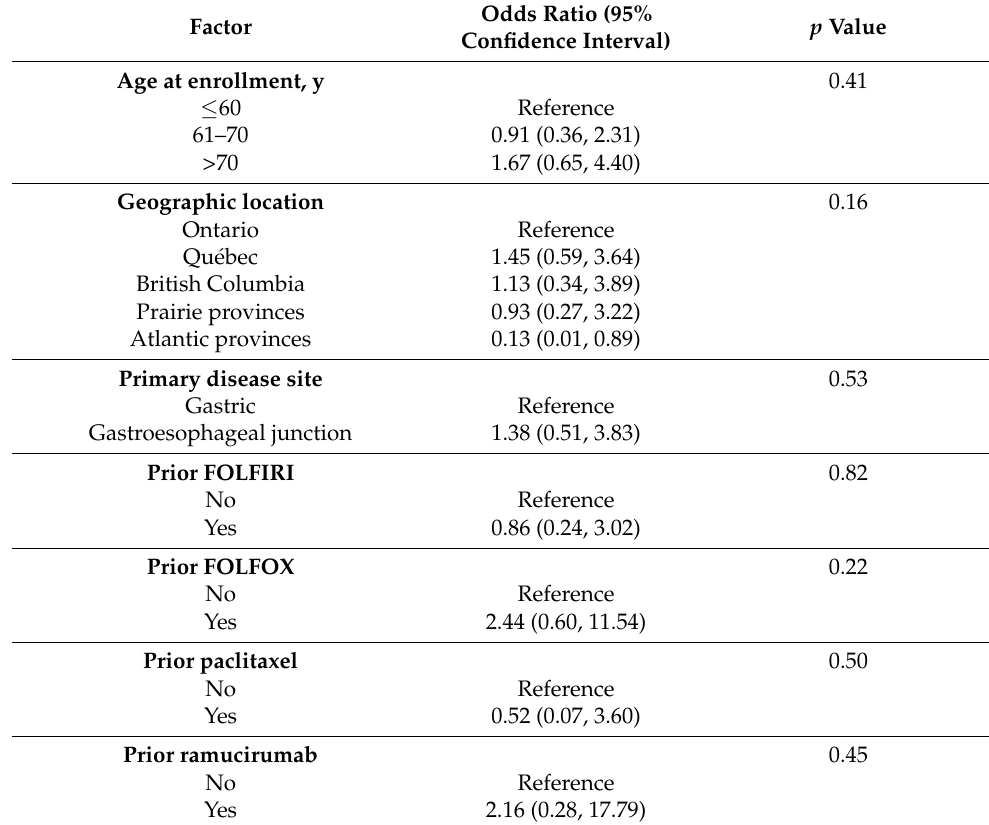
Table 5. Multivariable logistic regression analysis of predictors of trifluridine/tipiracil discontinua- tion due to disease